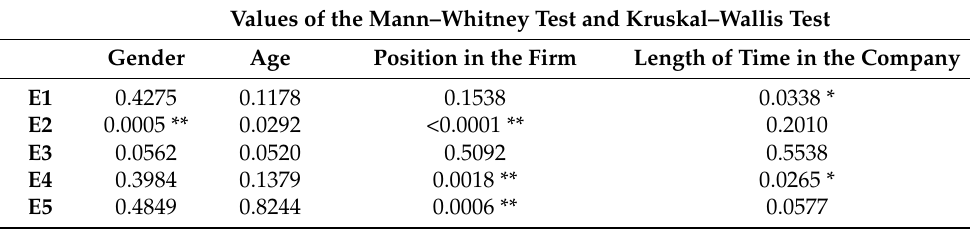
Table 4. Results of the Mann–Whitney test and the Kruskal–Wallis